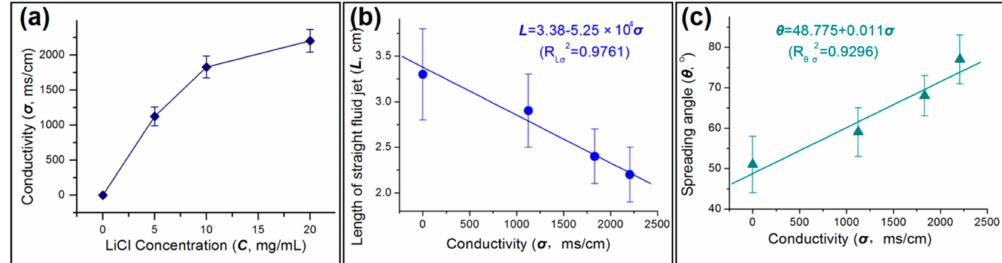
Figure 6. The influence of the sheath fluid conductivity on the behavior of the working fluids: ( a ) The relationship between LiCl concentration and solution conductivity; ( b ) the decrease in the length of the straight fluid jet with an increase of conductivity; ( c ) the increase of spreading angle with rising